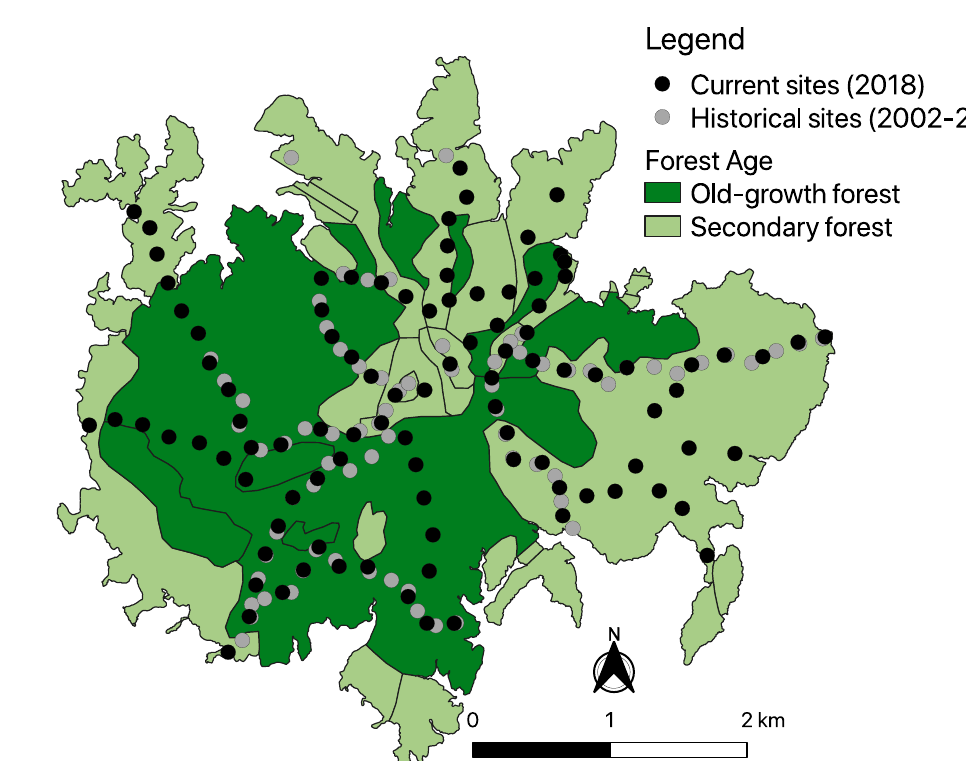
Figure 1. Map of Barro Colorado Island and distribution of forests of different ages (adaptation from [31]). The grey circles represent the historical sampling sites (2002–2005), and the black circles represent the most recent sampling sites (2018).